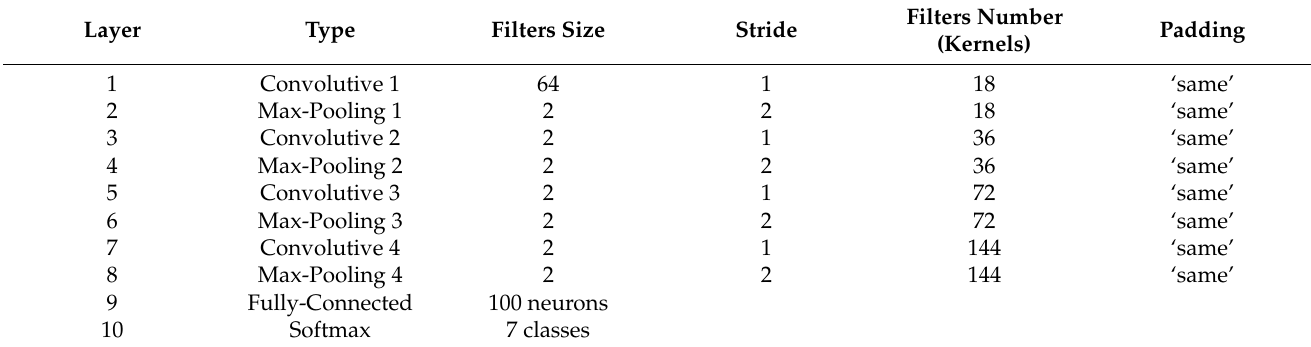
Table 4. 1D-CNN structure.